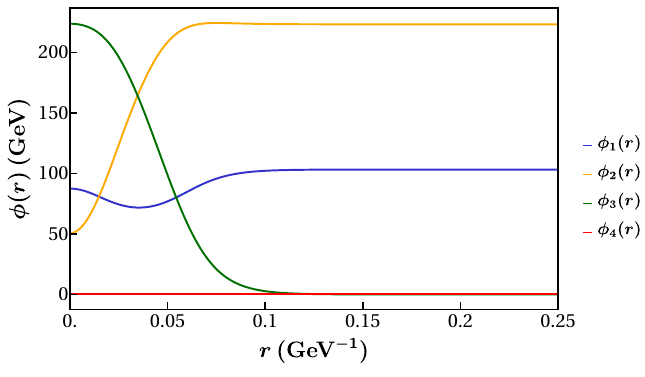
Figure 1 . Bounce solution ( (cid:30) 1 , (cid:30) 2 , (cid:30) 3 , (cid:30) 4 ) for the C2HDM. The (cid:12)fth bounce for (cid:30) 5 is identical to that for (cid:30) 4